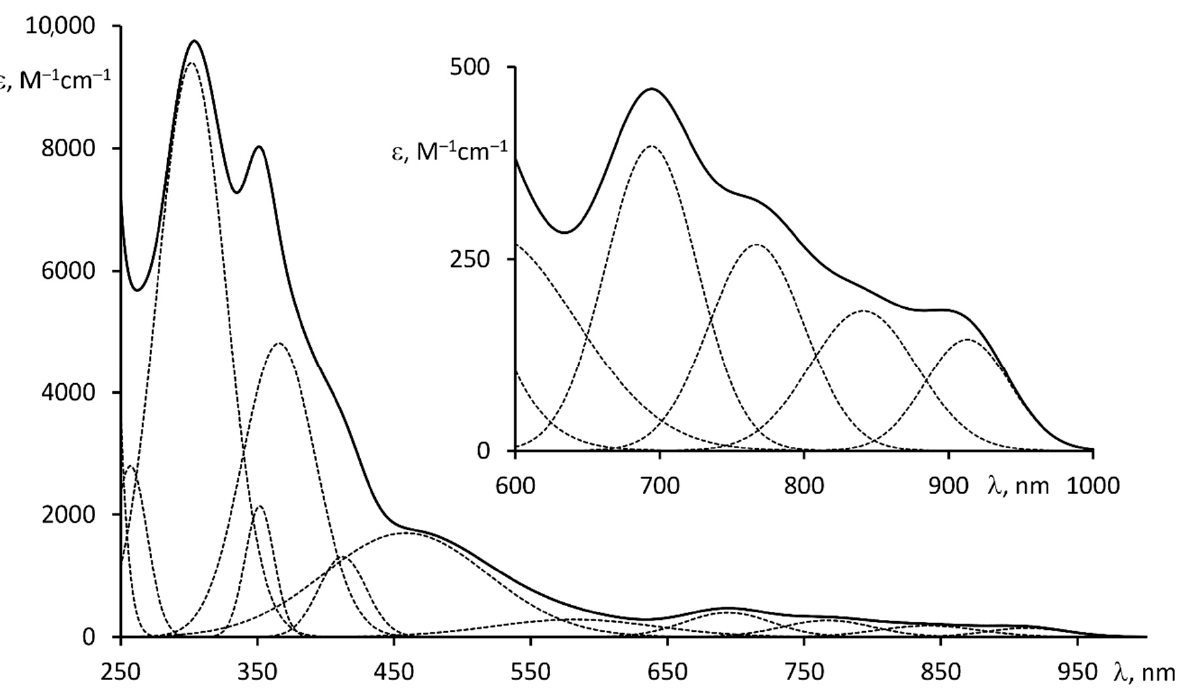
Figure 7. UV-Vis spectrum of complex 2 measured in degassed acetonitrile at 20 °C with deconvo- lution into its Gaussian components.